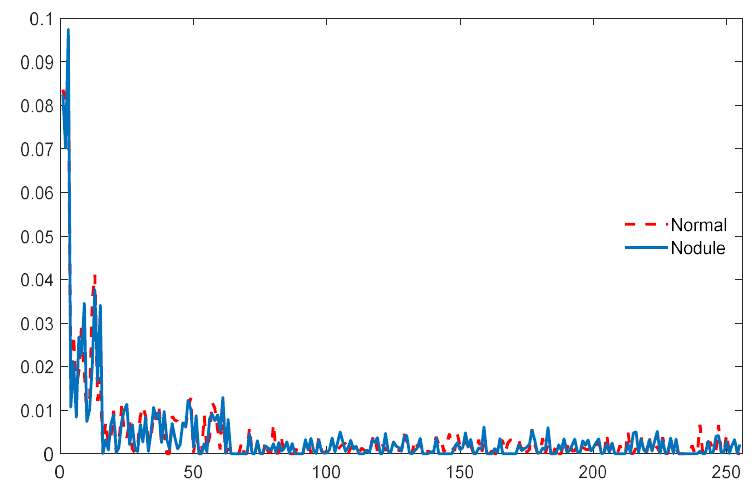
Figure 8. PHOG features obtained with the sample test images of Normal/Nodule class.